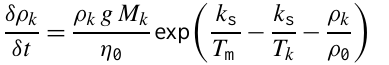
Canopy radiation and